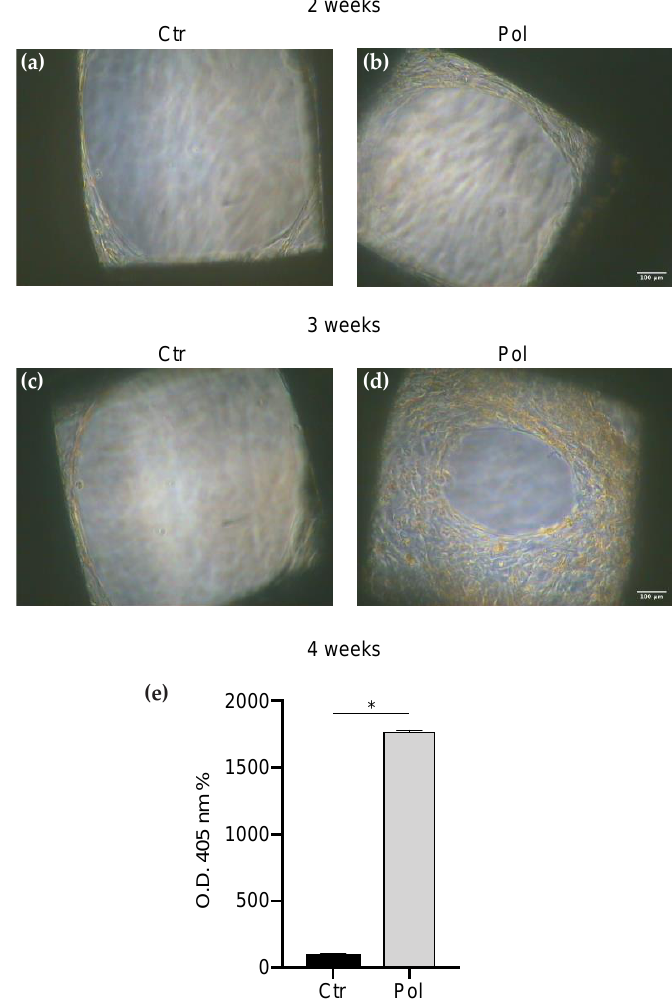
Figure 4. DBSCs proliferation and mineral matrix deposition on small pore scaffolds. ( a – d ) Representative phase contrast pictures of DBSCs treated with Pol or not (Ctr) for 14 days ( a , b ) and 21 days ( c , d ) in osteogenic conditions on scaffolds presenting pores of small dimensions (0.75 mm). Scale bar = 100 μm. ( e ) The graph shows ARS quantification using the OD as mean percentage ± SD and is representative for three independent experiments performed in quadruplicates. * p < 0.001. Student’s t -test was used for single comparisons. The biomaterial pores of a representative experiment were chosen for the figure.